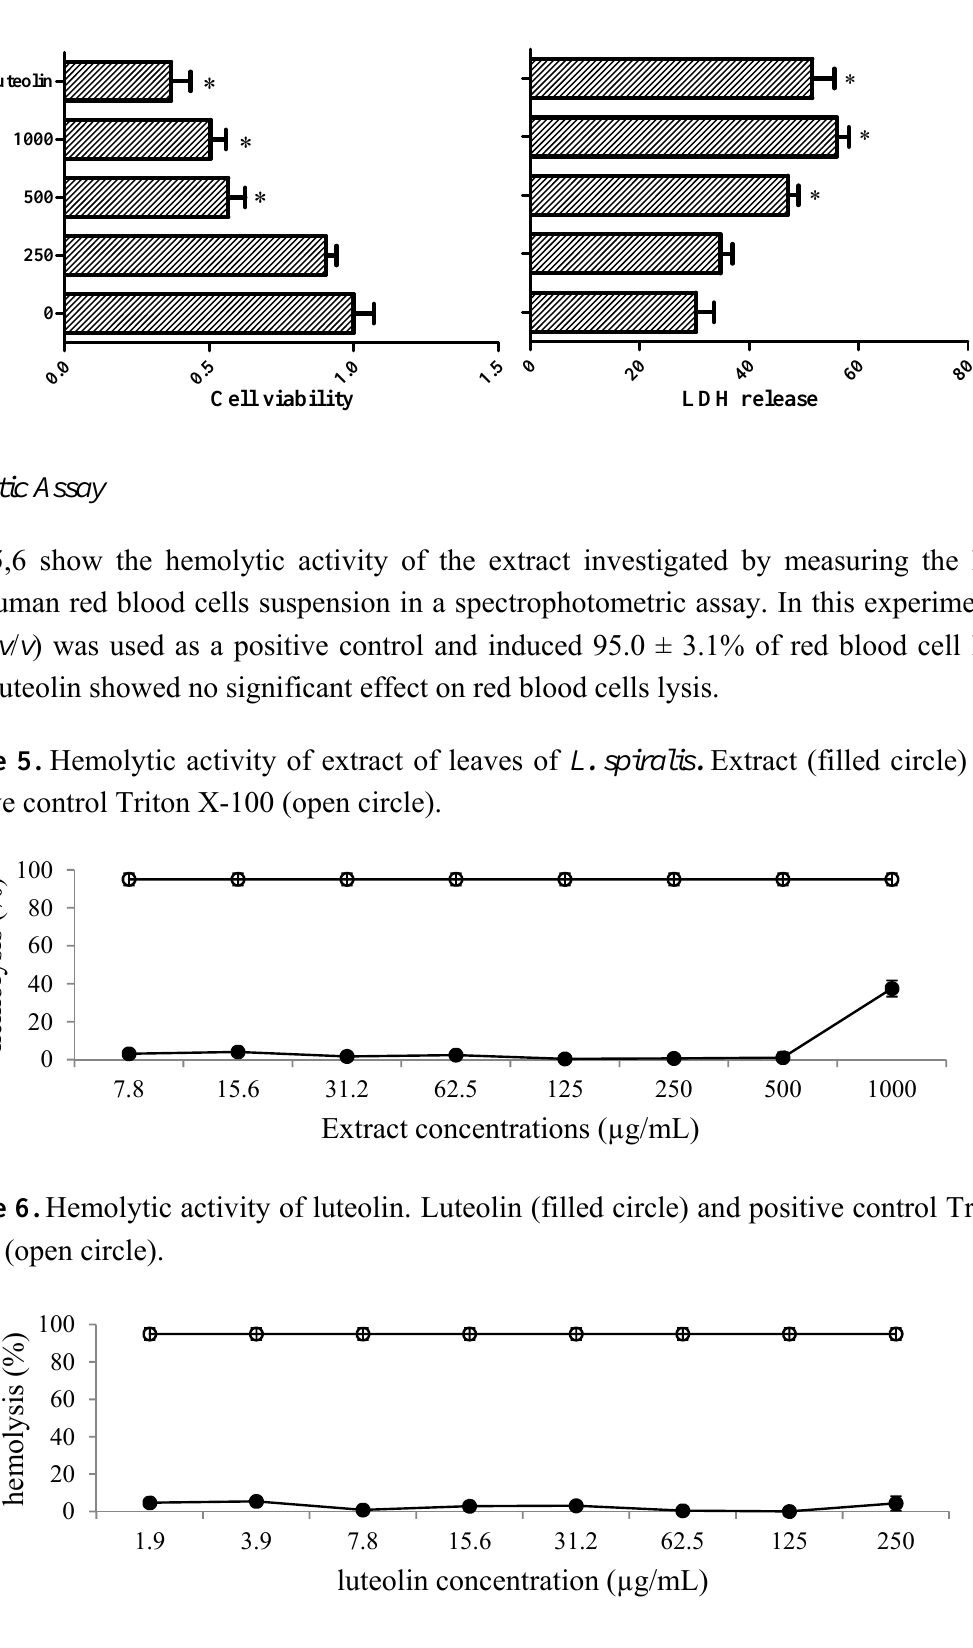
Figure 4. Effect of extract on cell viability and LDH release in cultured HeLa cells. Cells were treated with different concentrations of extract, and luteolin (31 mg/L) was used as positive control.* Significantly different from the basal conditions.